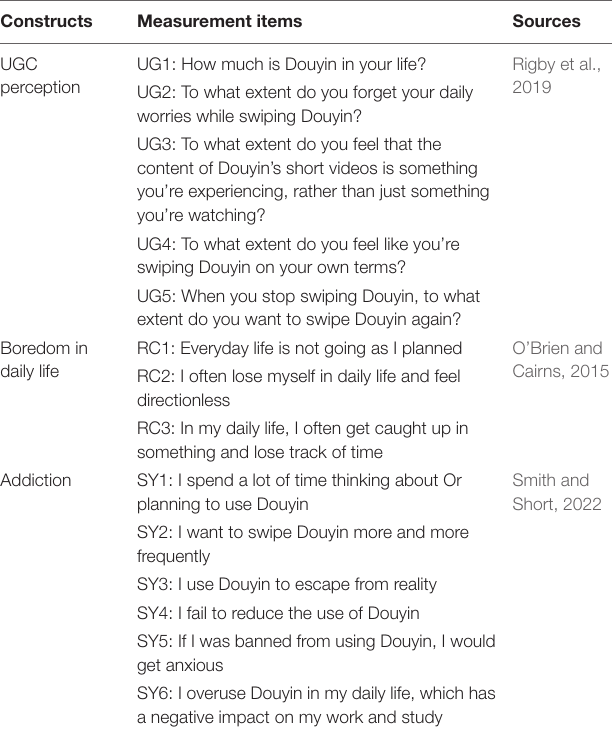
TABLE 4 | Setting and source of factor items.